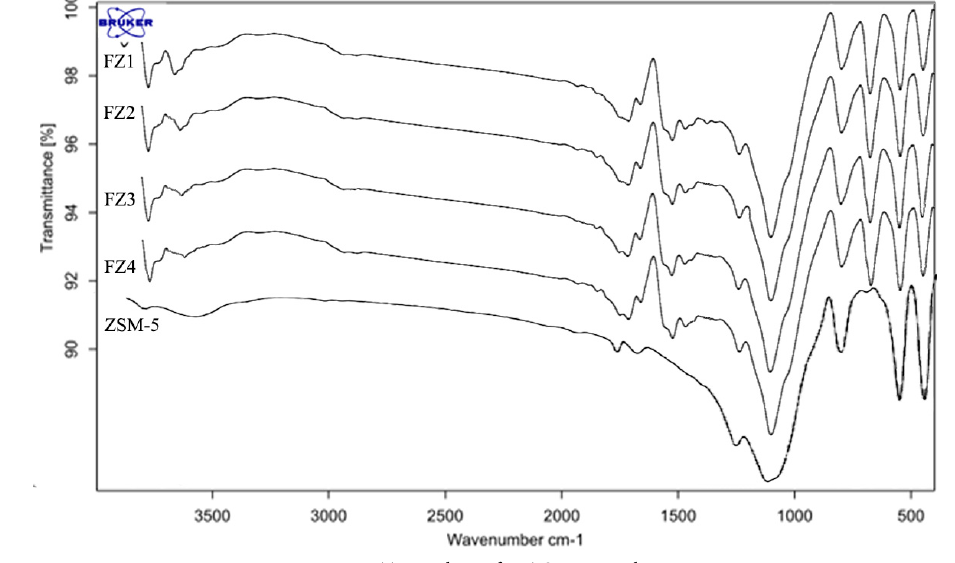
Fig. 7. FTIR analysis of Fe-ZSM-5 samples